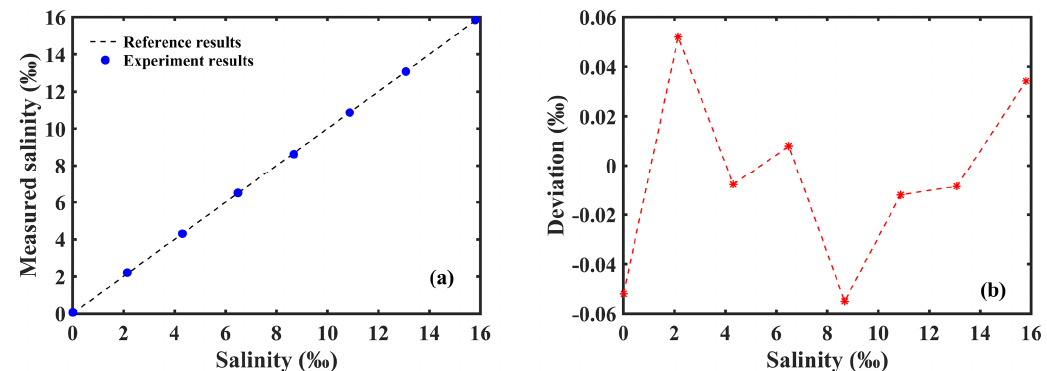
Figure 11. ( a ) Results obtained using salinity sensor and our method. Blue solid circle: our method results, black dashed line: the salinity sensor results; ( b ) the difference between our method and the salinity sensor.